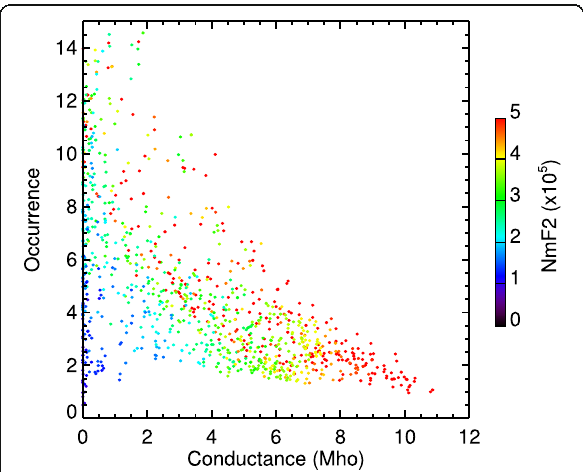
Fig. 19 Daytime TIG echo occurrence versus Pedersen conductance from the IRI model. Each point is color coded according to the corresponding value of the F region peak density NmF2 , with the scale shown on the right. Reproduced from Fig. 5 of Kane et al.